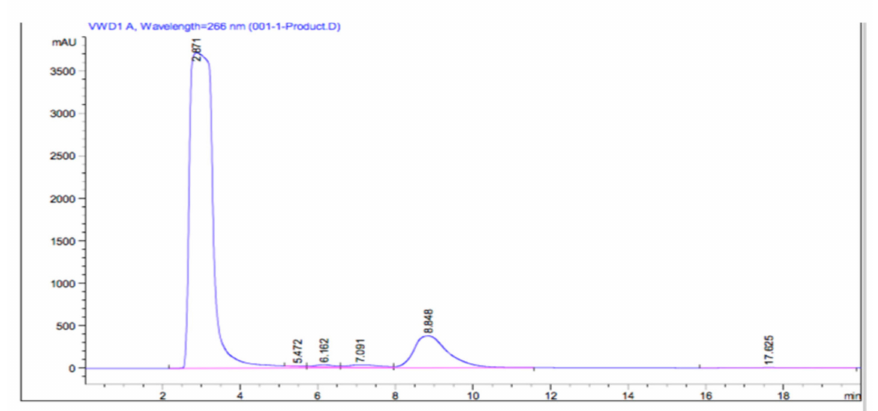
Figure 4. High-performance liquid chromatography (HPLC) chromatogram of pyrogallol